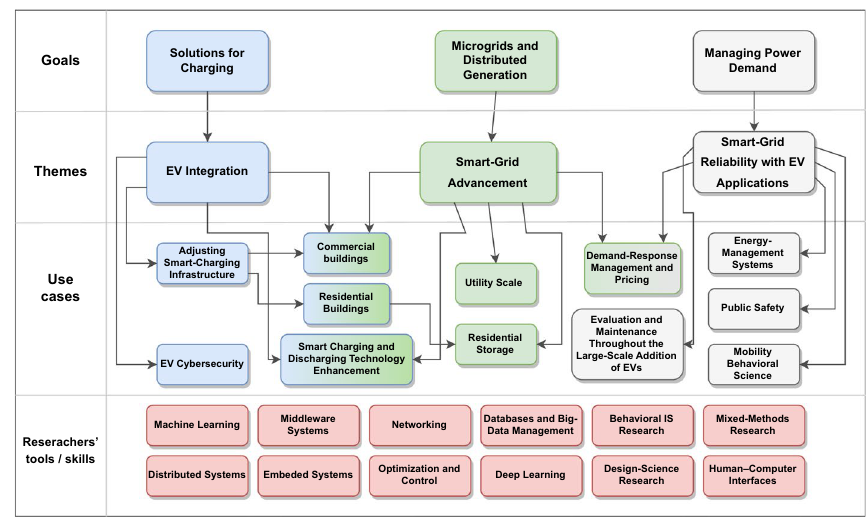
Fig. 1 Smart-Grid–EV integration